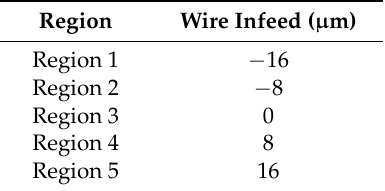
Table 3. Wire infeed values during the experiment in the different regions of the